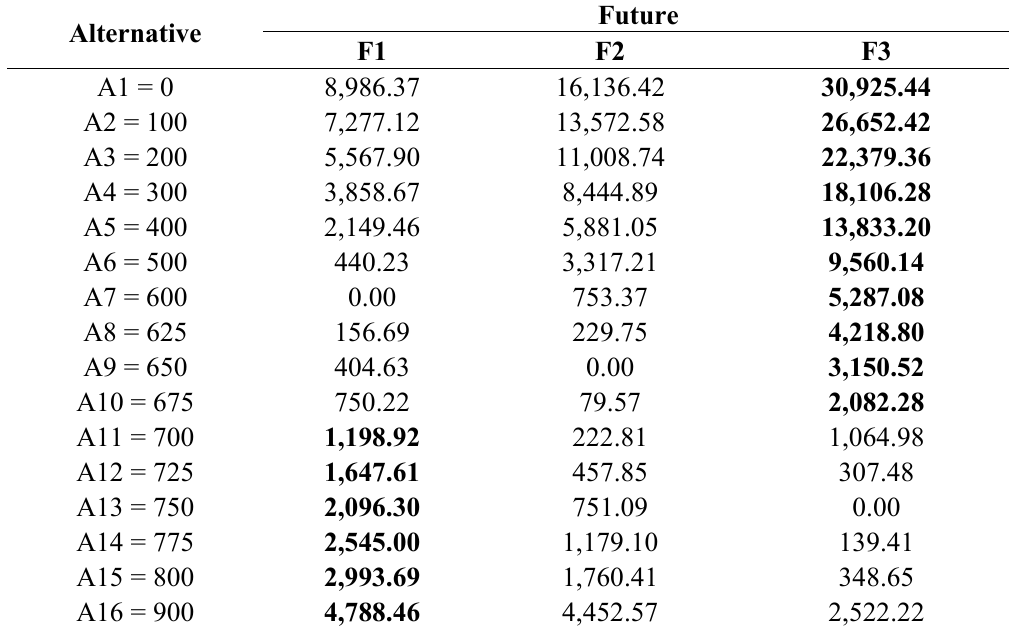
Table 2. Decision matrix of weighted regrets ($)—Case